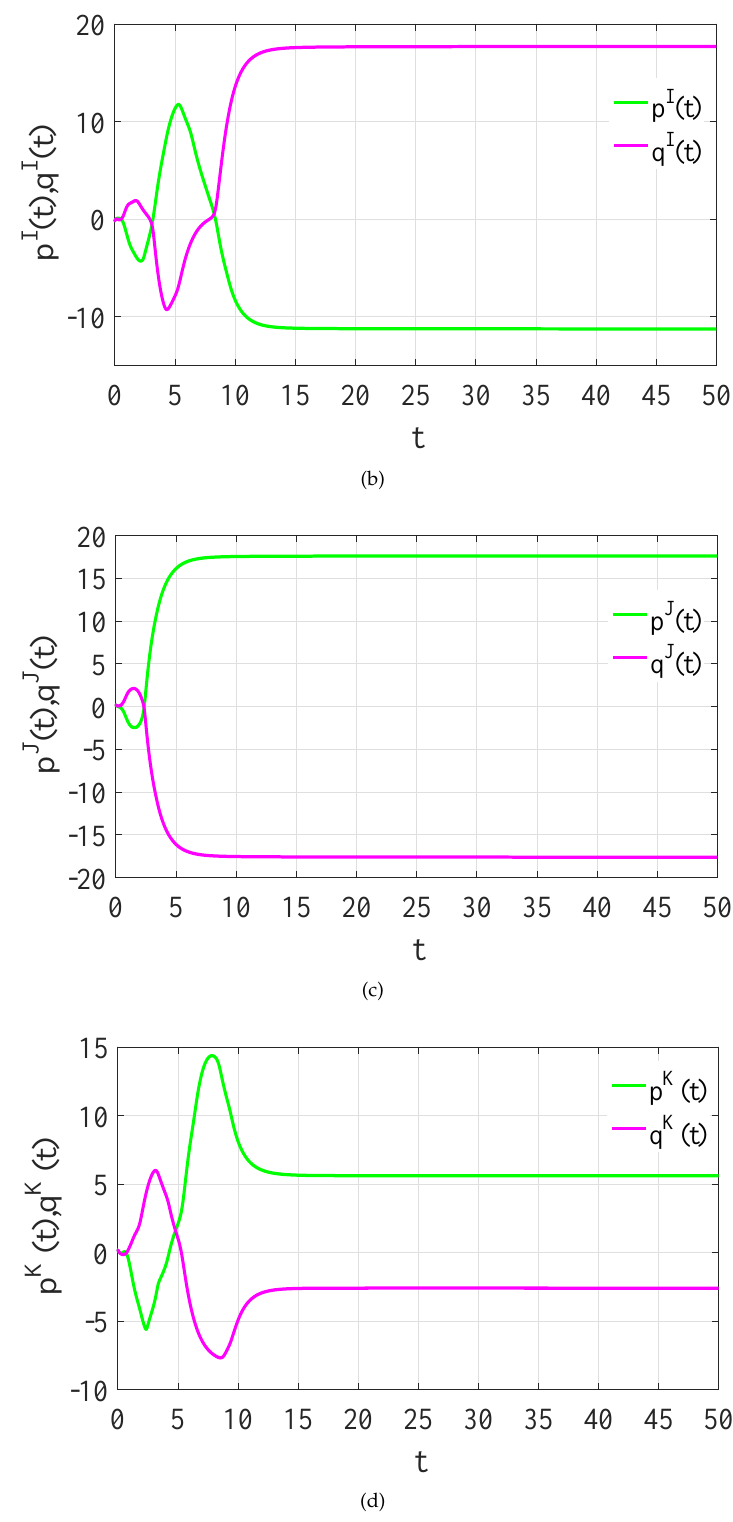
Figure 3. State trajectories of systems (16) and system (17) without controller when γ = 0.98. ( a ) p R ( t ) and q R ( t ) ; ( b ) p I ( t ) and q I ( t ) ; ( c ) p J ( t ) and q J ( t ) ; ( d ) p K ( t ) and q K ( t )